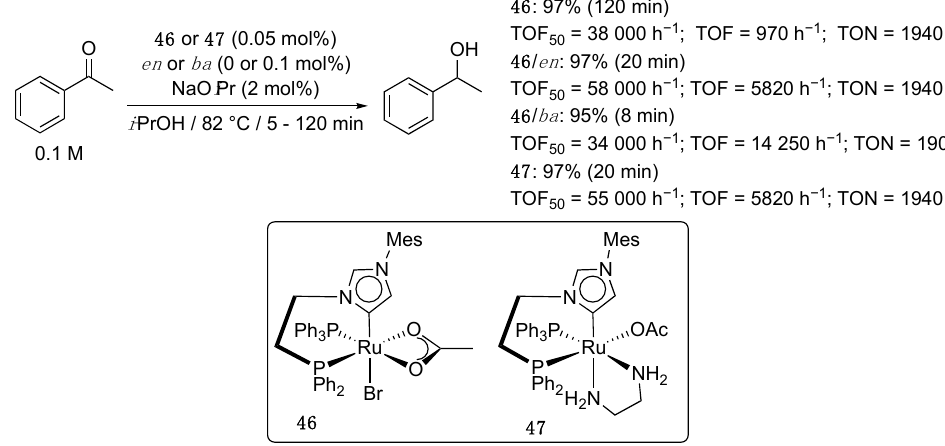
Scheme 22. TH of acetophenone catalyzed by the